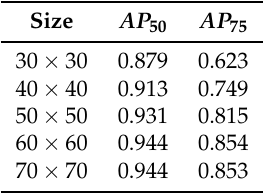
Table 3. Average precision for different fixed size bounding boxes using ATSS.